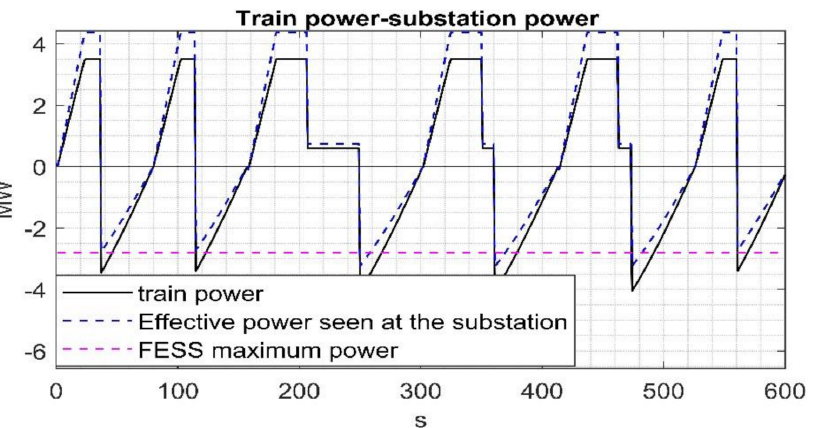
Figure 5. Train power and substation power during the